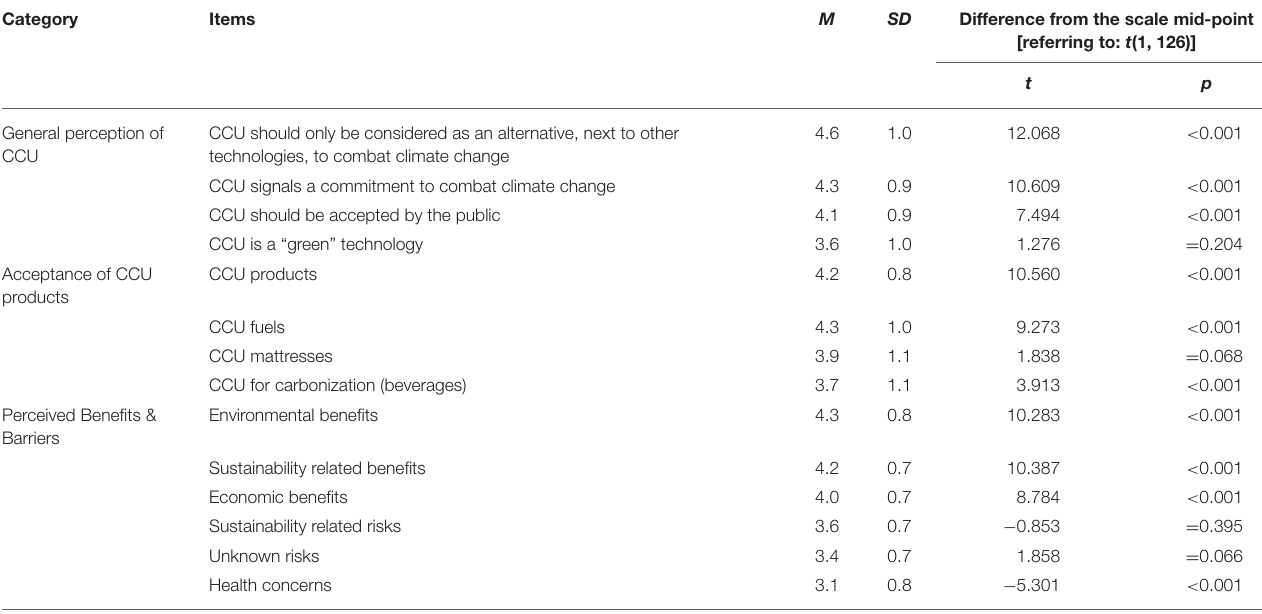
[referring to: t (1, 126)] t p